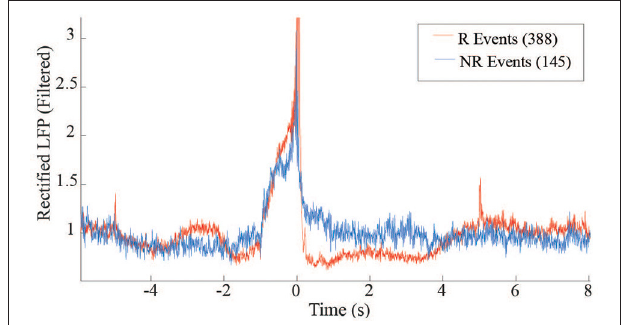
FIGURE 9 | LFP power differences between R and NR reward events in free behavior conditioning. Band-passed (10–30Hz) and rectified LFP signals were averaged across events occurring during R (red trace) and NR (blue trace)